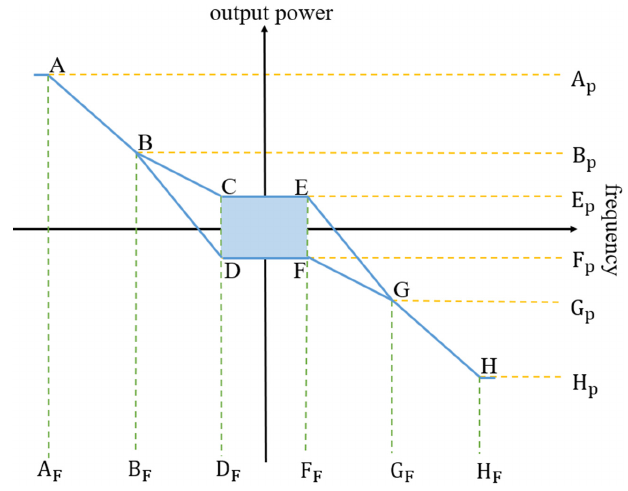
Figure 1. The response curve of the dReg mode.